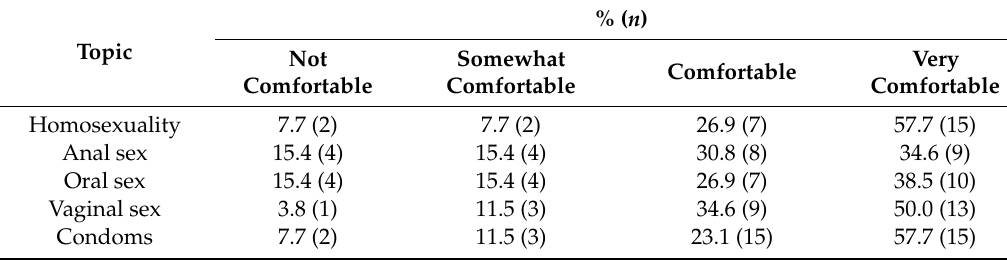
Table 1. Distribution of faith leaders’ comfort level discussing sexual health topics with youth ( n = 26).